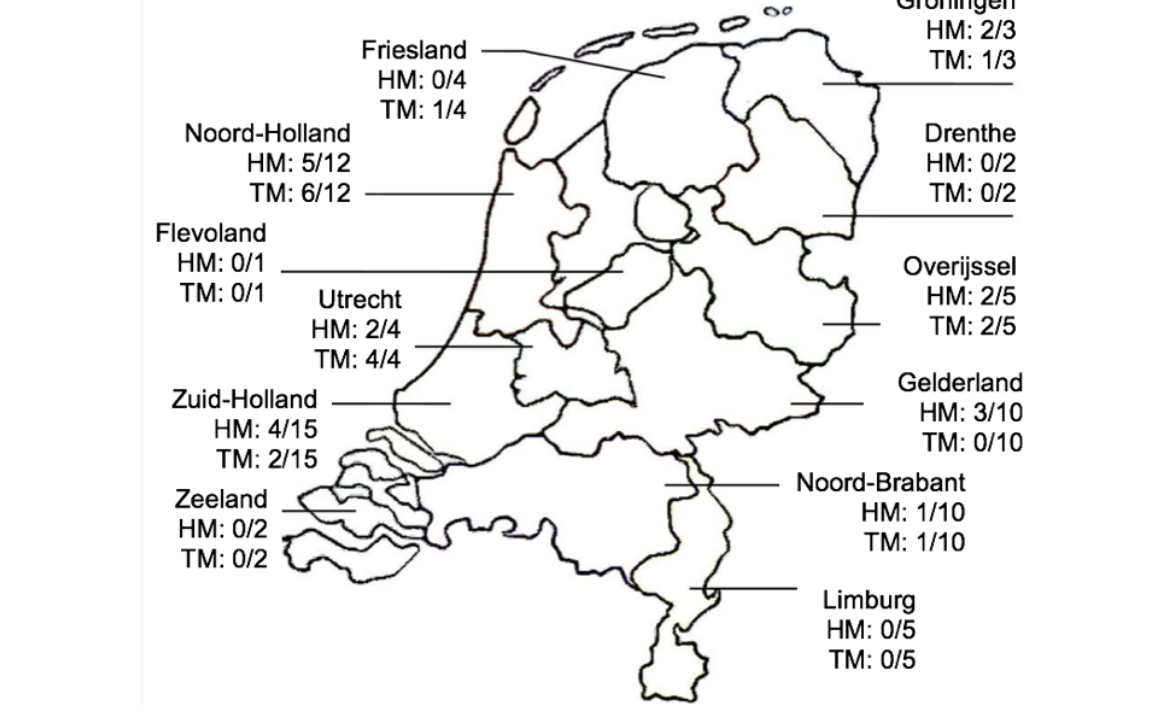
Figure 2. Geographic distribution of home-based monitoring and telemonitoring in 12 provinces of the Netherlands (N=73). HM: hospitals with